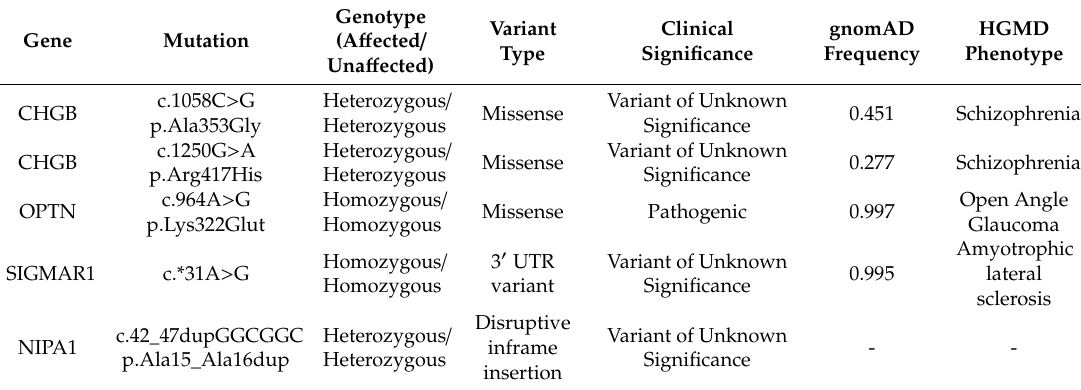
Figure 1. Successful reprogramming of induced pluripotent stem cells (iPSCs) from discordant identical twins. Two independent clones from each patient express the pluripotency markers Oct4 ( A ) and Sox2 and Tra 1-81 ( B ), detected by immunocytochemistry. Scale bar = 50 µ m. ( C ) The transcript levels of Sox2, Oct4, and Nanog are similar to an established iPSC line by qPCR. ( D ) Embryoid body sections from each patient express markers of the three germ layers, including β -III tubulin (Tuj1, ectoderm), smooth muscle actin (SMA, mesoderm), and α -fetoprotein (AFP, endoderm) detected by immunocytochemistry. Scale bar = 25 µ m. Table 2. Abridged list of identified variants in genes listed in Amyotrophic Lateral Sclerosis Online Database